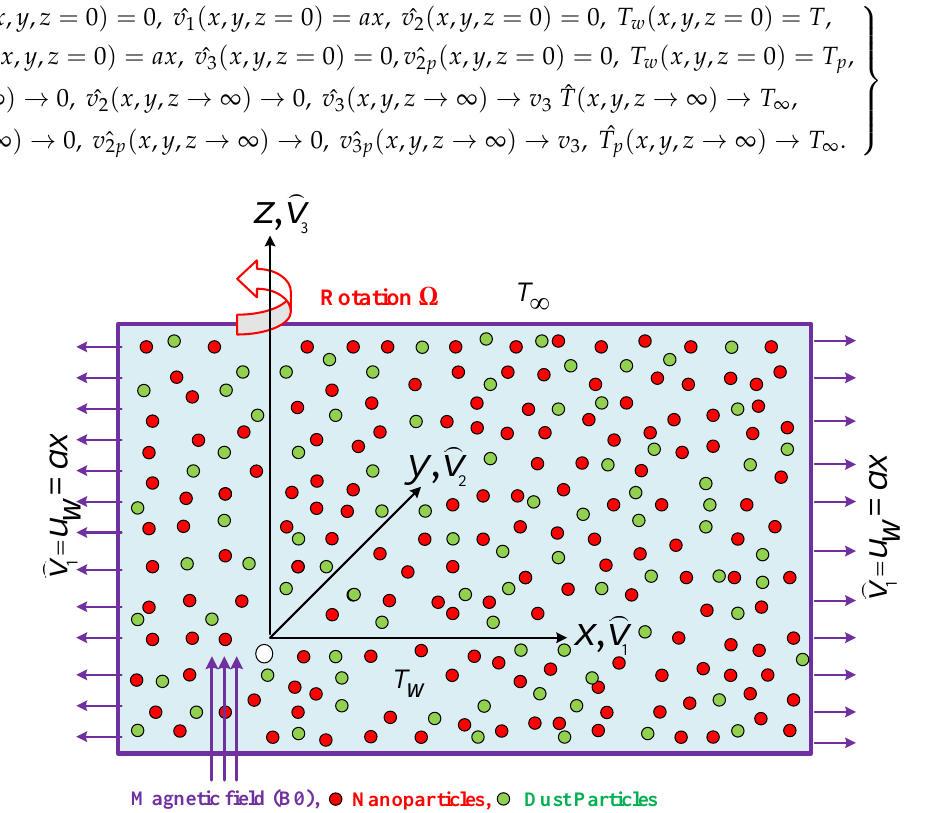
Figure 1. The physical configuration of non-Newtonian dusty